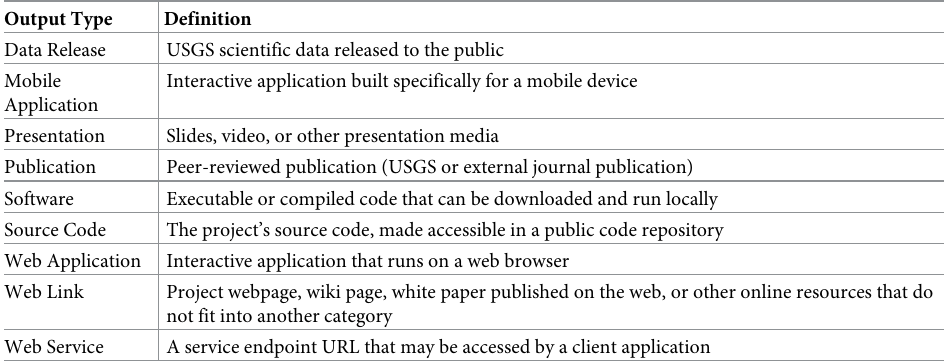
Table 4. Community for data integration project output types and